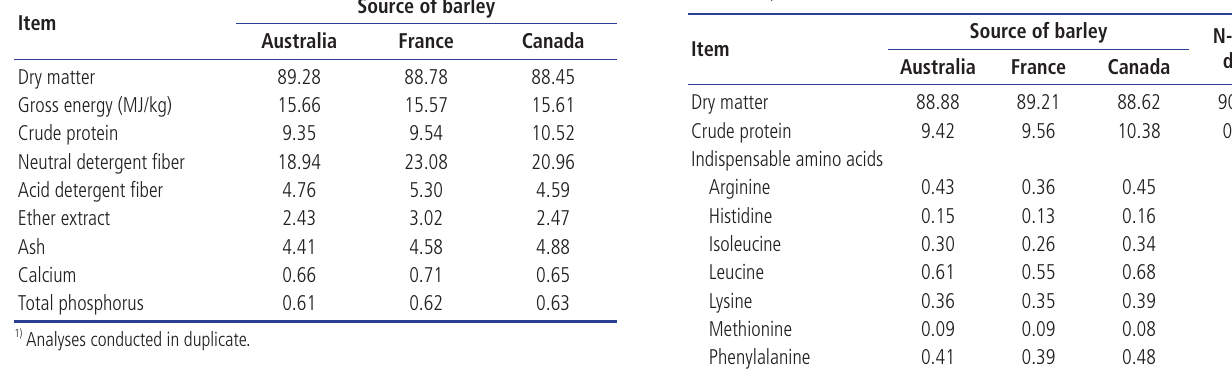
Table 4. Analyzed chemical composition of the experimental diets used in Exp. 2 (% as-fed basis) 1)